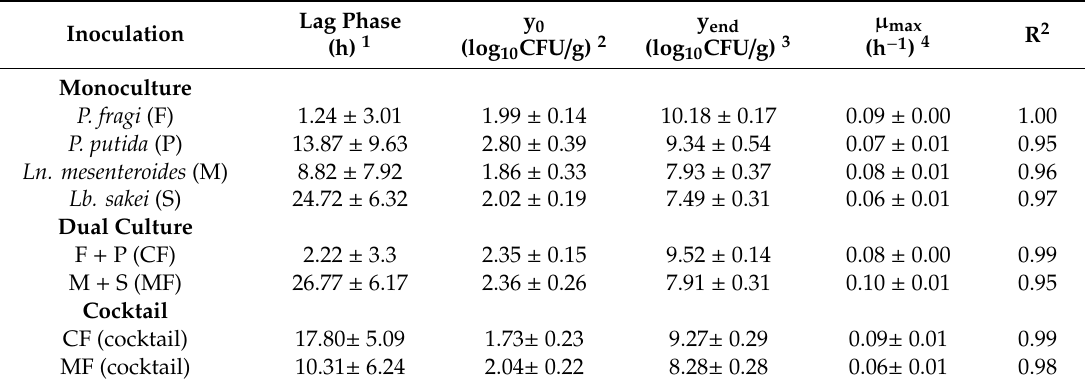
Table 2. Estimated kinetic parameters of di ff erent microbial groups in sterile pork meat stored at 10 ◦ C.